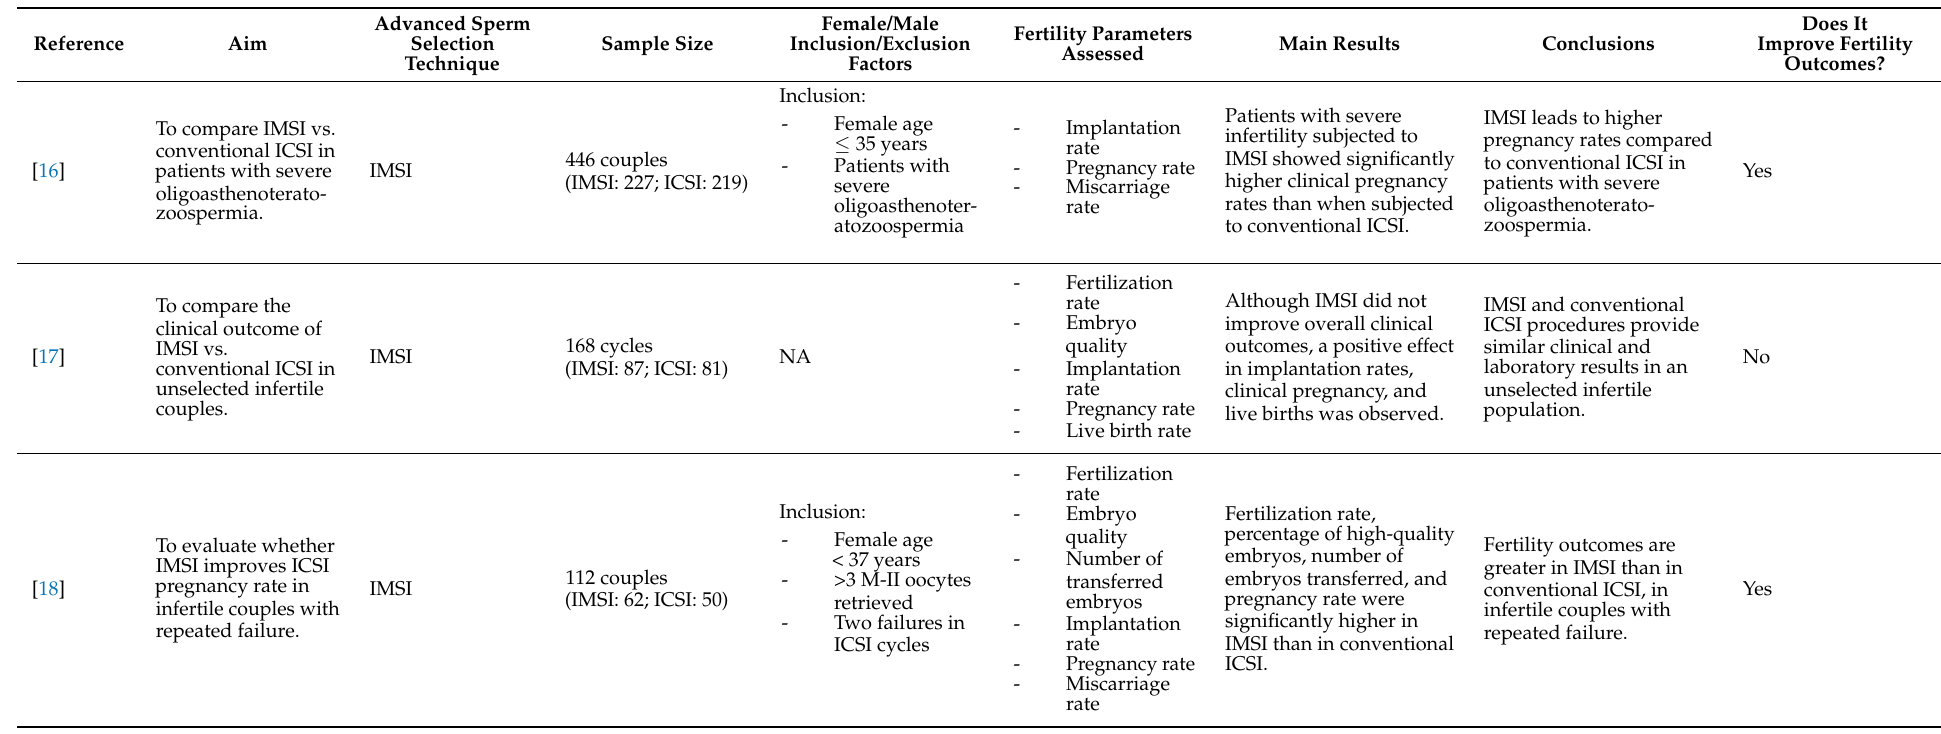
Table 2. Relevant data of articles included in the systematic review. Abbreviations: ART: assisted reproduction technology; BMI: body mass index; FSH: follicle stimulating hormone; ICSI: intra-cytoplasmic sperm injection; IMSI: intra-cytoplasmic morphologically selected sperm injection; IVF: in vitro fertilization; MII: metaphase II; MACS: magnetic-activated cell sorting; MSOME: motile sperm organelle morphology examination; PICSI: physiological intra-cytoplasmic sperm injection; PVP: